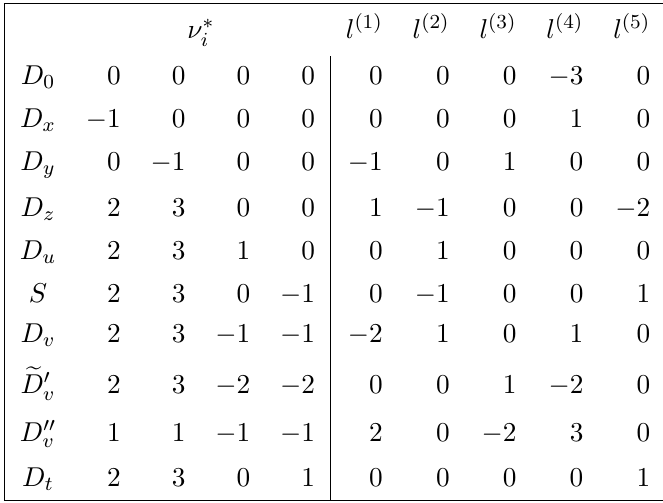
Table 4 . Toric divisors and Mori cone generators of the toric variety whose anti-canonical divisor is the compact embedding of the E-string geometry with two (cid:13)avor masses turned on breaking SU(3) (cid:26) E 8